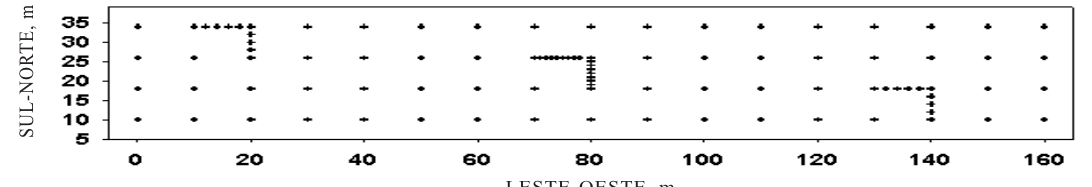
Figura 1. Esquema de amostragem realizada na área experimental.